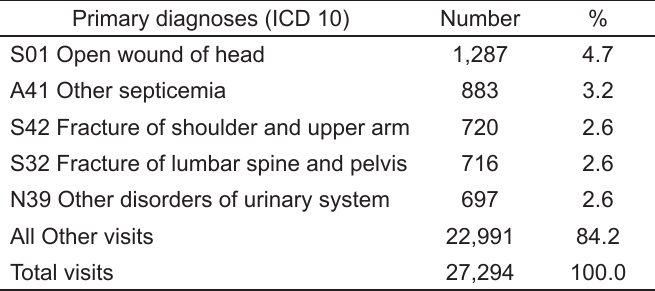
Table 4. Top five primary diagnoses associated with seven-day emergency department